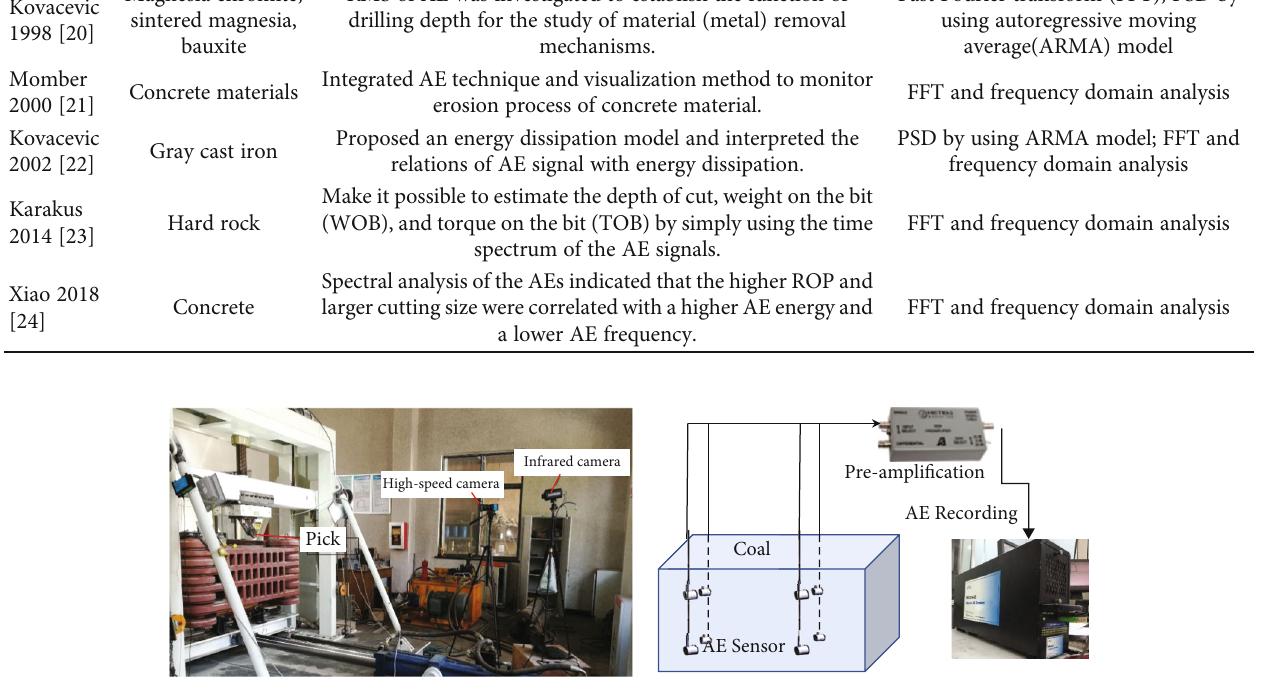
Figure 2: A schematic of the experimental setup.